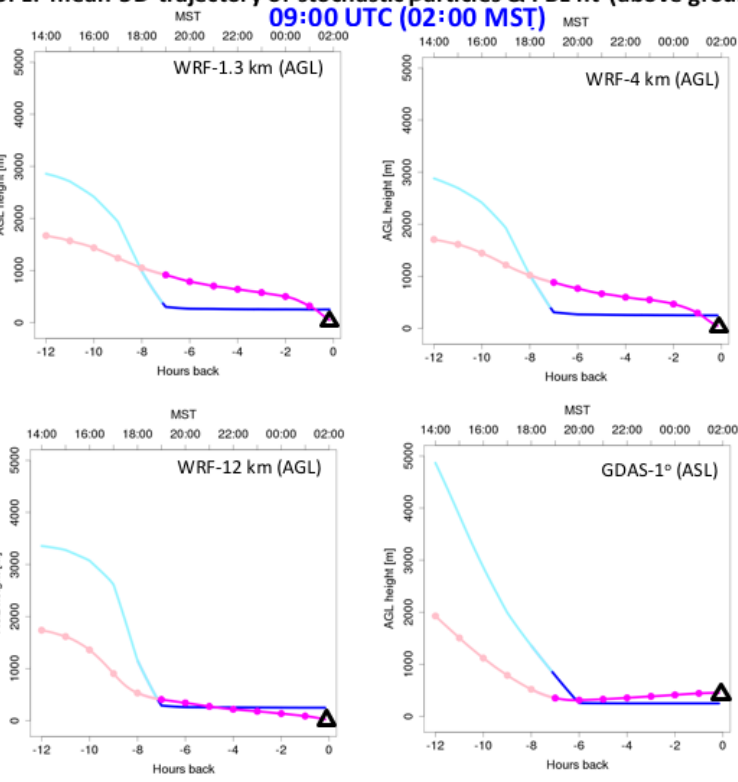
Figure 10. Similar to Fig. 8, but for the Storm Peak Laboratory (SPL)